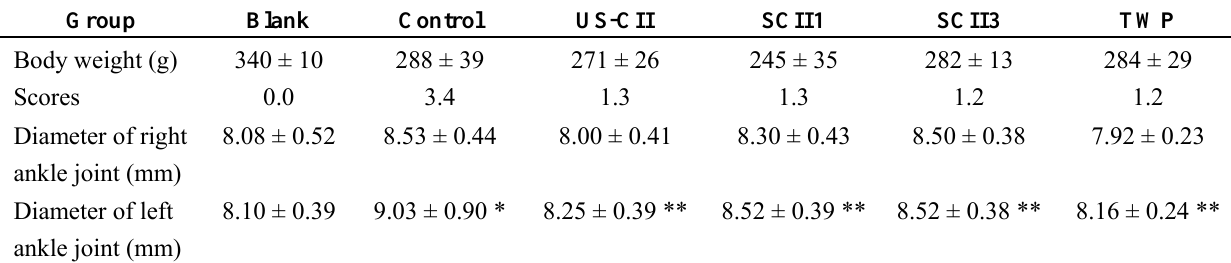
Table 2. The clinical manifestations for each experiment group after keeping administrating corresponding drug for 2 weeks.